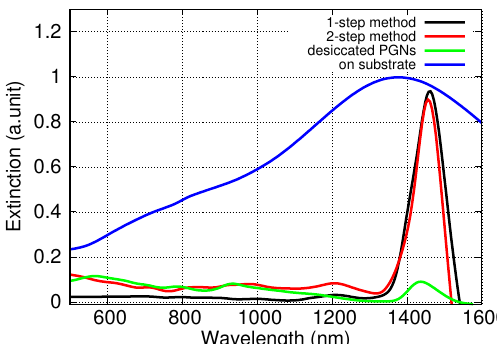
Figure 2. Optical absorption spectra of supported PGNs on sapphire substrate and support-free PGNs suspended in water or desiccated in sapphire. (Black and red lines: Spectra of the support-free PGNs in water prepared by the one-step and two-step detachment methods, respectively. Green line: Spectrum of support-free PGNs desiccated on sapphire. Blue line: Reference spectrum of supported PGNs on sapphire.).